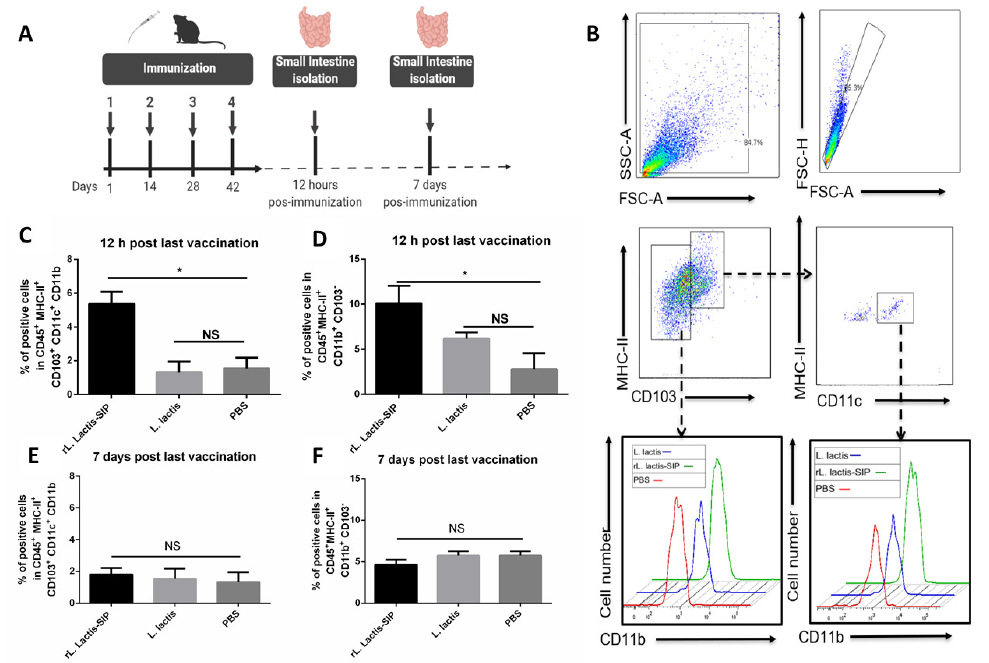
Oral vaccination with rL. lactis -SIP enhanced intestinal antigen-presenting cells in gut-associated lymphoid tissue. ( A ) Representation of the immunization used in C57BL / 6 mice experiment. The mice (per group) were orally immunized four times with 1 × 10 10 rL. lactis -SIP at intervals of 14 days. ( B ) Representative plots for DCs in the intestine for oral vaccinated mice are shown. Gut-associated lymphoid tissue (GALT) living CD (cluster of di ff erentiation)-45 + MHC (major complex of histocompatibility)-II + were analyzed for CD103 + and CD103-negative cell expression and consequently the resulting populations were separated for CD11c and CD11b. The mice in the control groups were immunized with 1 × 10 10 CFU of L. lactis or PBS. At 12 h ( C , E ) or 7 days ( D , F ) after the last immunization, cells were isolated from the entire small intestine and stained with anti CD45- anti-MHC II, anti-CD103 + anti-CD11b + , and anti-CD11c + . Levels of indicated populations of cells expressing various levels of CD11b were analyzed further for CD103 expression. A total of 30,000 events was acquired in all the experiments using a FACSverse cytometer and analyzed with Flowjo software. Results represent one of two independent experiments with similar results. Data are shown as mean ± SD of four mice in each group. Asterisks indicate a significant di ff erence versus PBS control (not significant (ns); * p < 0.05).